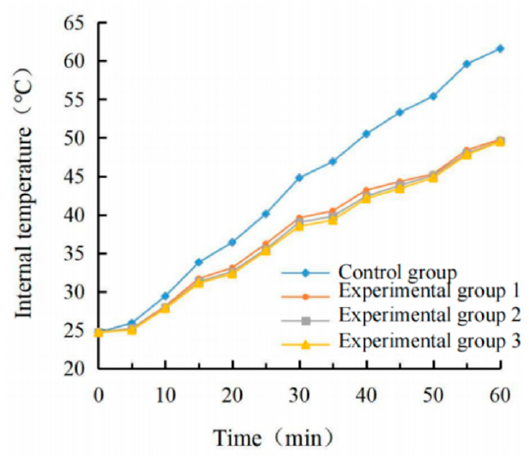
Figure 14. Internal temperature diagram.